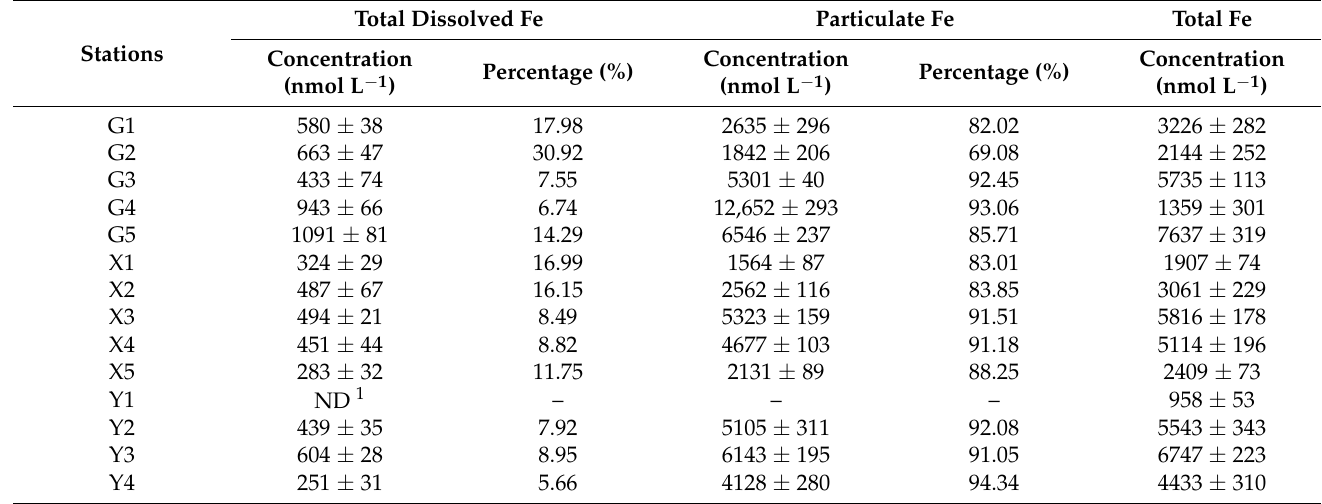
Table 2. The concentrations of different fractions of Fe in coastal river waters at 14 stations in the study area.